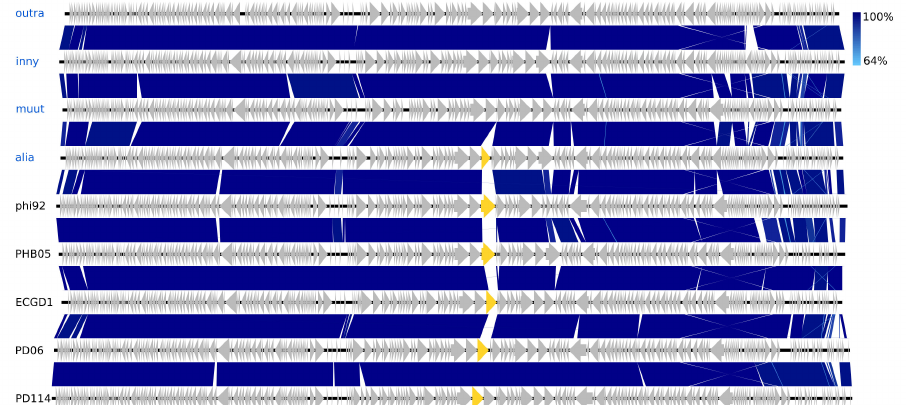
Figure 3. Pairwise alignment of the unclassified Myoviridae phage species from this study (blue text) and their closest relatives (black text), the color bars between genomes indicate percent pairwise similarity (Easyfig, BlASTn). The genes marked with yellow code for a tailspike (gene 143 in